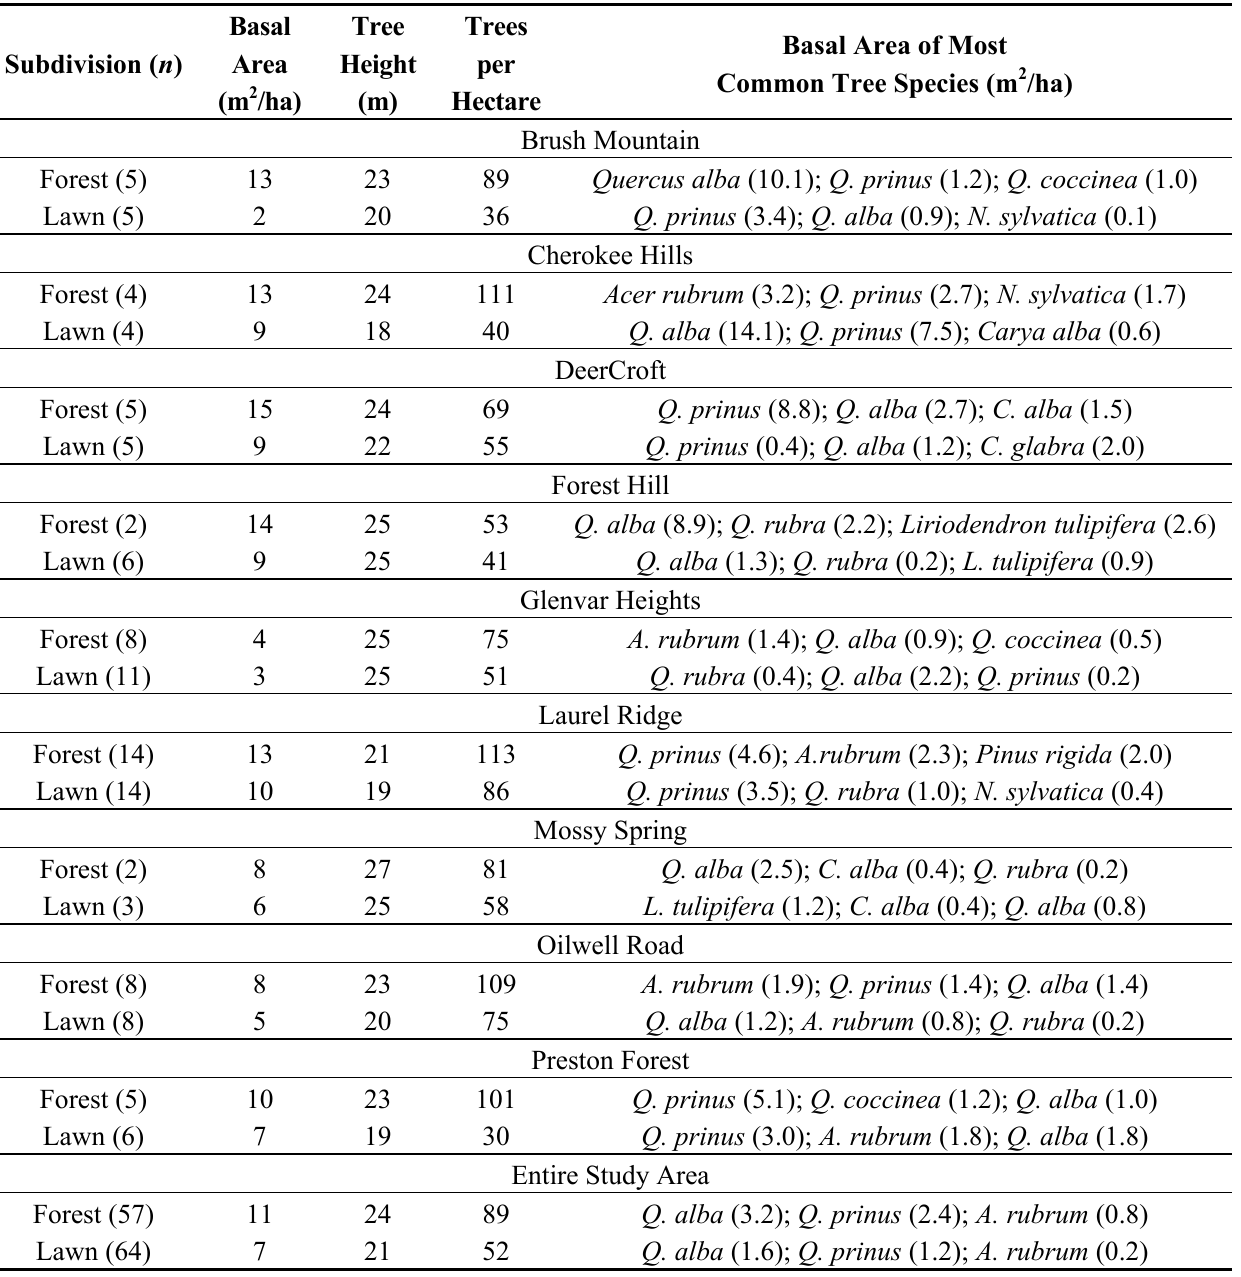
Table 1. Tree measurement data for mixed oak forests and adjacent residential lawns (grouped by subdivision) located in the Valley and Ridge physiographic province of southwest Virginia. Each value is the mean of all sample plots ( n ) for each landscape type within each